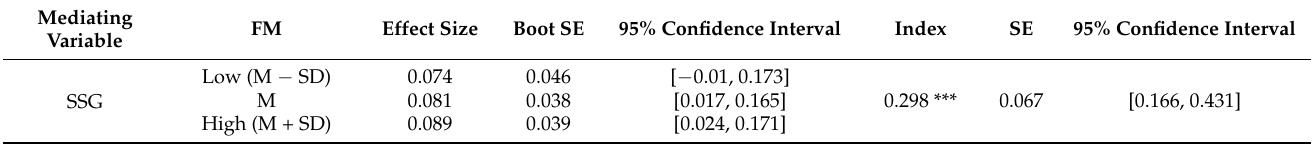
Table 6. Bootstrap test result of moderated mediation model.